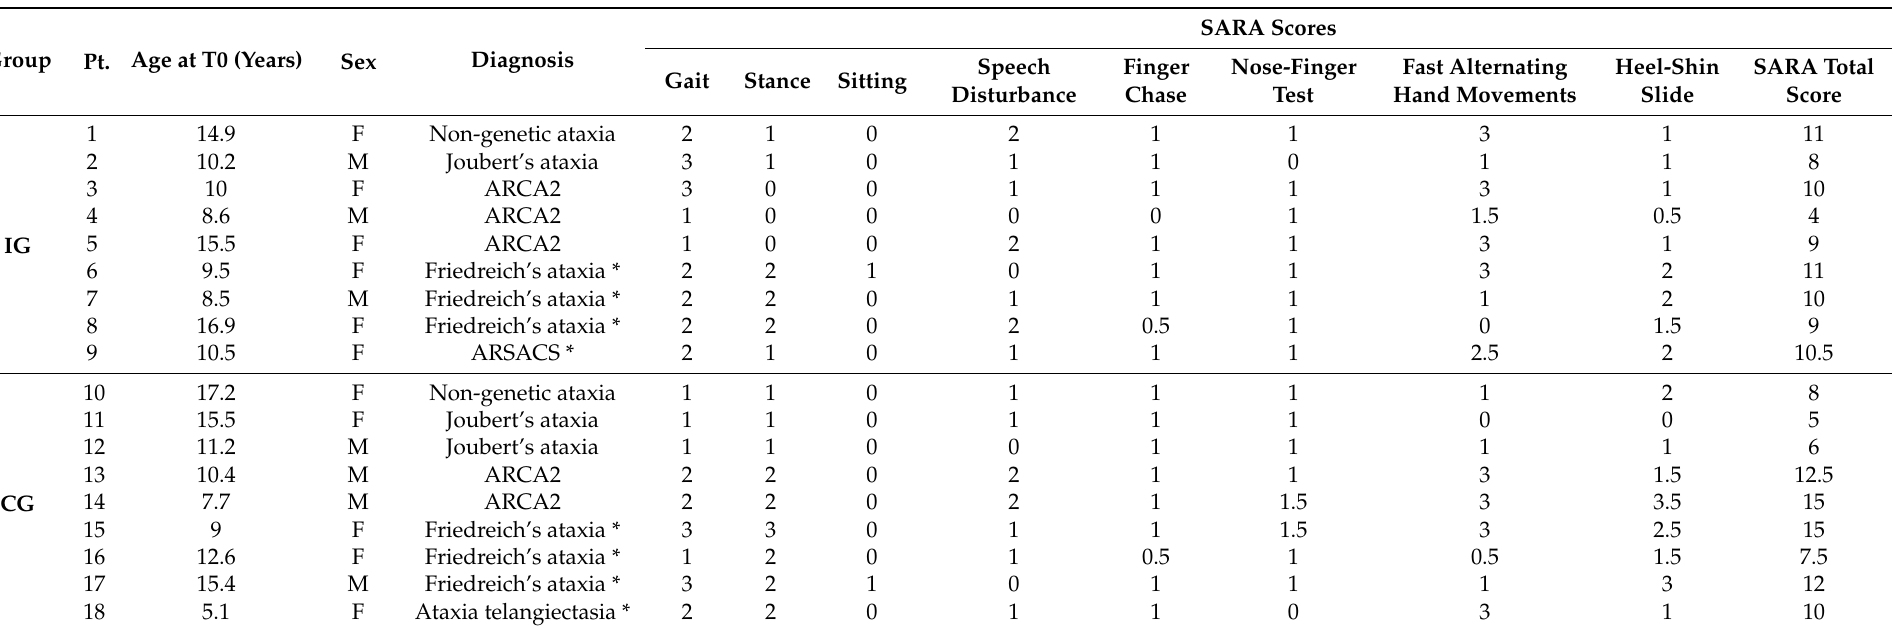
Table 1. Participants’ group, age at baseline (T0), diagnosis, and SARA items and total scores. The horizontal line separates the data obtained from participants in the IG and